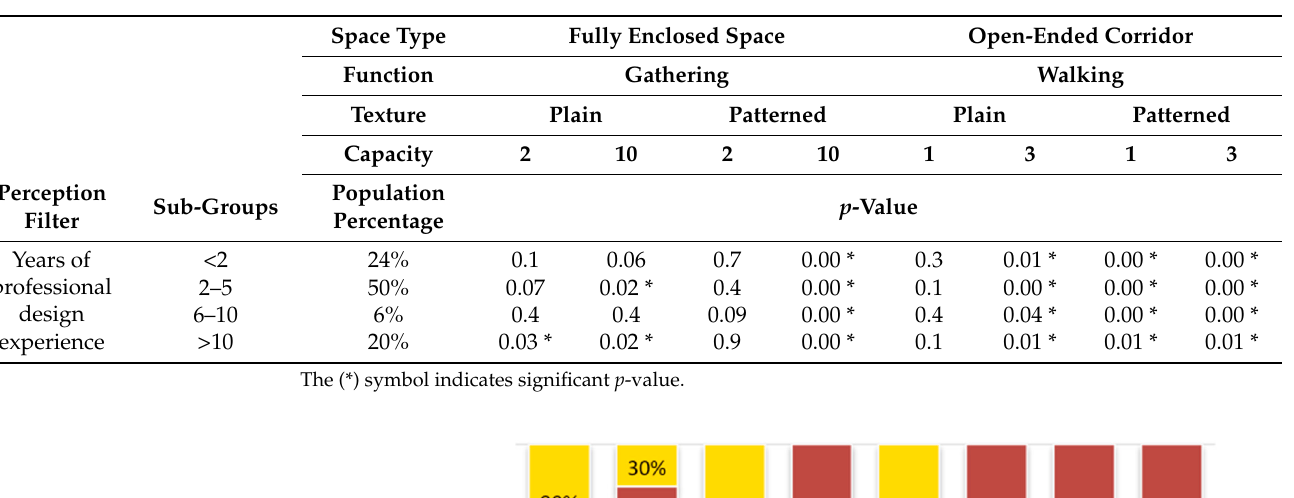
Table 7. Period of professional design experience perception filter and comparisons of space size variations between IVRIE and DT systems.